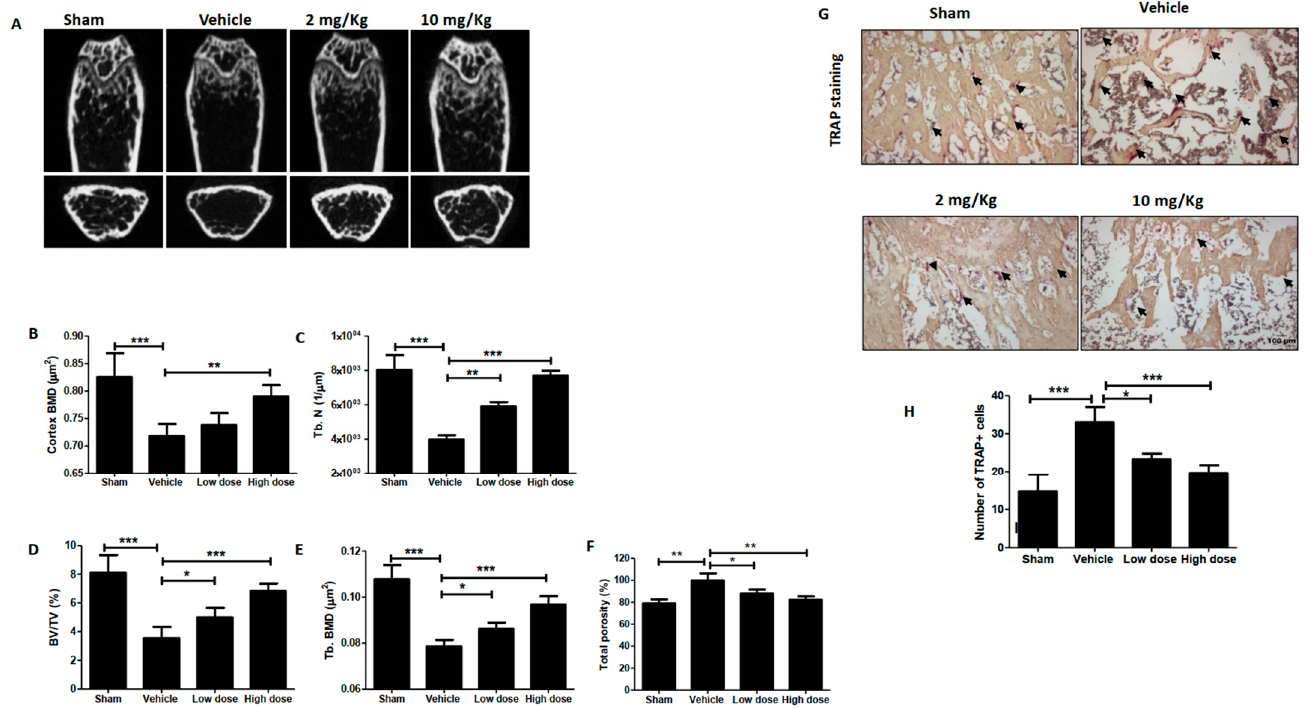
Figure 6. KT inhibits osteolysis in vivo. ( A ) MDA-MB-231 cells were intracardially injected into the mice. After five weeks with or without treatment of KT, representative micro-CT images of each group’s mice were shown. ( B – F ) BV/TV, trabecular separation, cortex BMD, trabecular number, trabecular thickness, trabecular BMD, and total porosity were determined using micro-CT data analysis. ( G ) Femurs were fixed, decalcified, embedded, and sectioned. TRAP staining of mice and osteoclast numbers in femurs were counted (Scale bar, 100 µ m). Arrows indicate mature osteoclasts. ( H ) Quantitative analysis of TRAP-positive osteoclast numbers displayed as a histogram. Results are presented as means ± S.D. ( n = 8). * p < 0.05, ** p < 0.01, and *** p < 0.001 indicate significant differences between KT-treated groups and